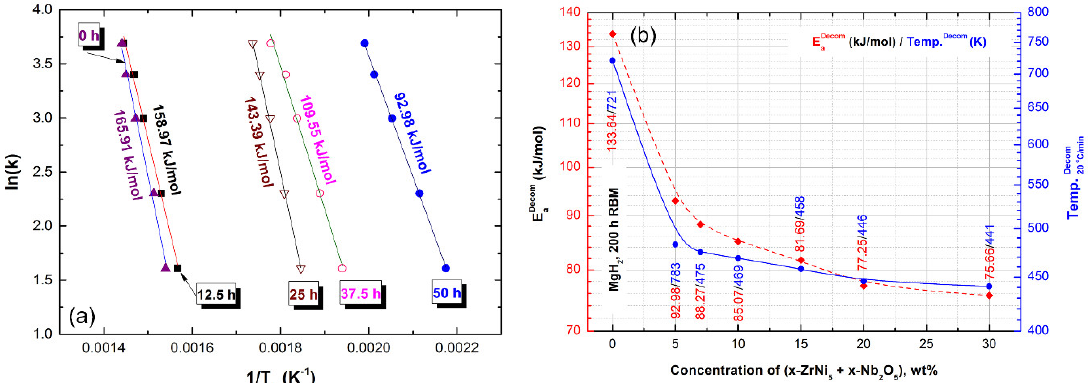
Figure 6. ( a ) Influence of milling time on the apparent activation energy of decomposition for nanocomposite MgH 2 /5 wt%(2.5 ZrNi 5 + 2.5 Nb 2 O 5 ) powders and ( b ) concentration effect of (x ZrNi 5 /x Nb 2 O 5 ) catalytic agent on apparent activation energy of decomposition (red sybmoles) and decomposition temperatures (blue symboles) for nanocomposite powders obtained after 50 h of milling. MgH 2 /5 wt%(2.5 ZrNi 5 + 2.5 Nb 2 O 5 ) powders that were obtained after 12.5 h of milling had